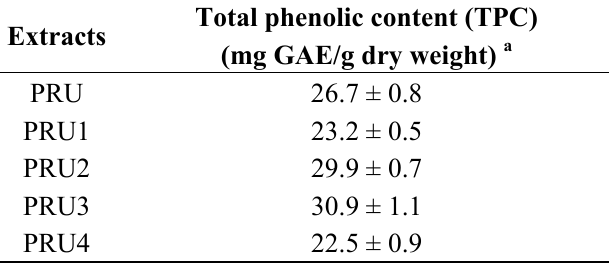
Table 1. Total phenolic content in the obtained extracts and their subfractions from D. rupestris .